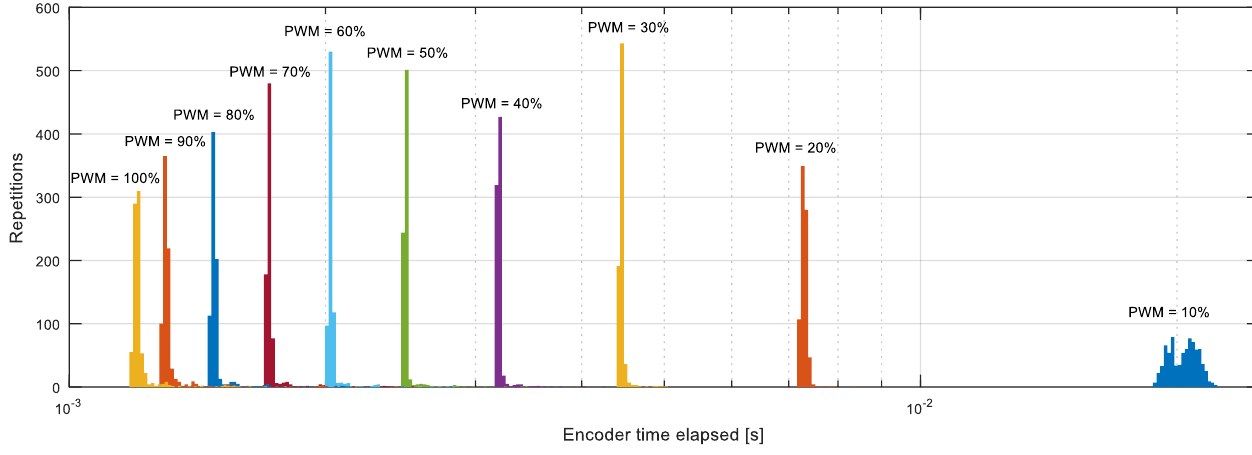
Figure 15. Histogram of the encoder ’s time-elapsed ( ∆𝑡 𝑘 ) values obtained with different PWM duty cycles (cases represented in Figure 9a with no load), colored in order to differentiate the cases analyzed.